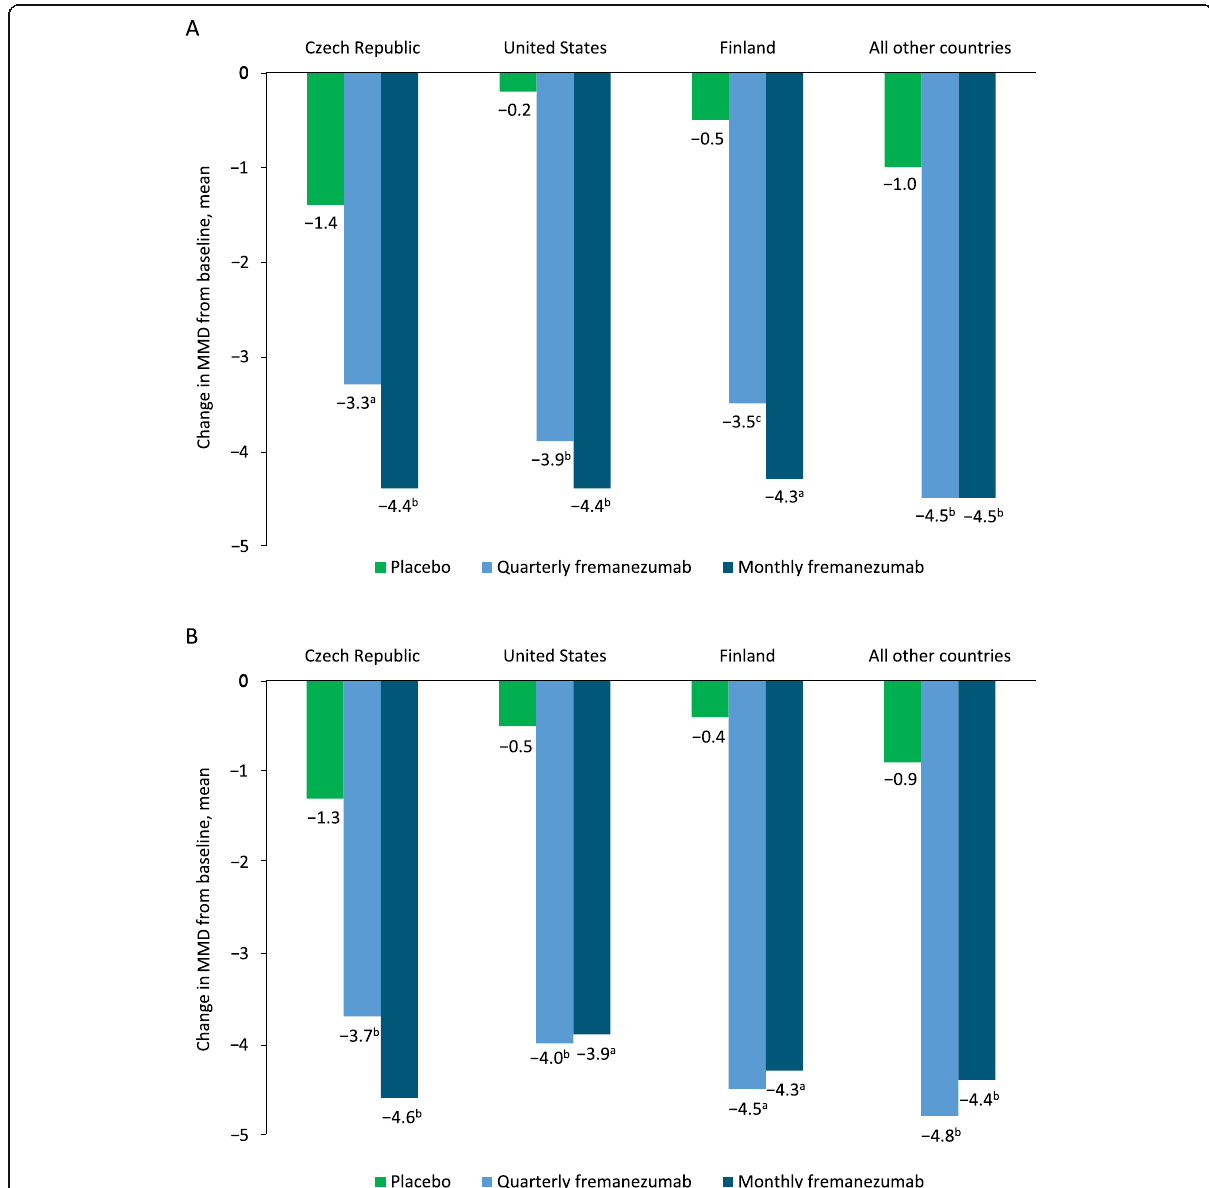
Fig. 1 Reductions in MMD from baseline in the 3 top-recruiting countries and all other countries during a ) 12 weeks and at b ) 4 weeks. MMD monthly migraine days. a P < 0.01 versus placebo. b P < 0.001 versus placebo. P < 0.05 versus